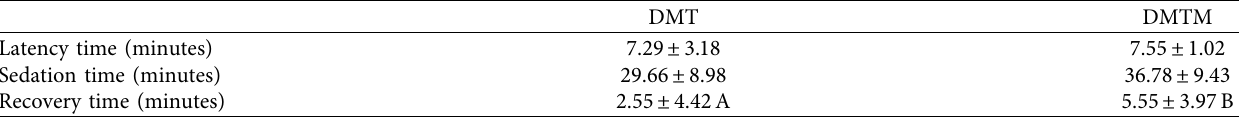
Table 2: Values of latency time, sedation time and recovery time in 18 felines sedated with the association of dexmedetomidine (7.5 ug/kg) and methadone (0.3mg/kg) (DMT, n � 9) or dexmedetomidine (5 ug/kg), methadone (0.3mg/kg), and midazolam (0.3mg/kg), both